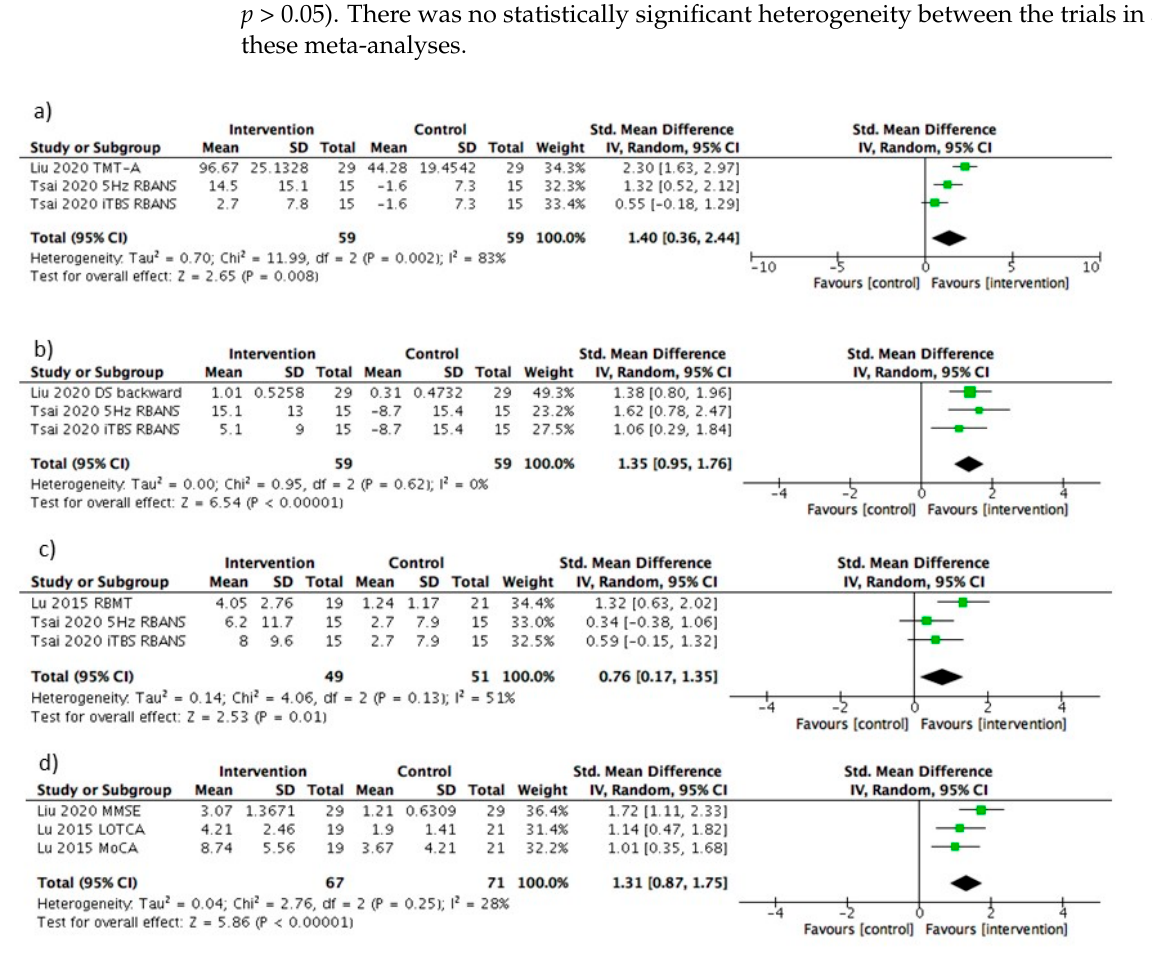
Figure 3. Forest plot of rTMS with neuropsychological tests outcome. ( a ) Attention, ( b ) Working memory, ( c ) Memory, ( d ) Cognition, Catherine Bergego Scale ; CI, confidence interval ; SD, standard deviation ; Std, standard.